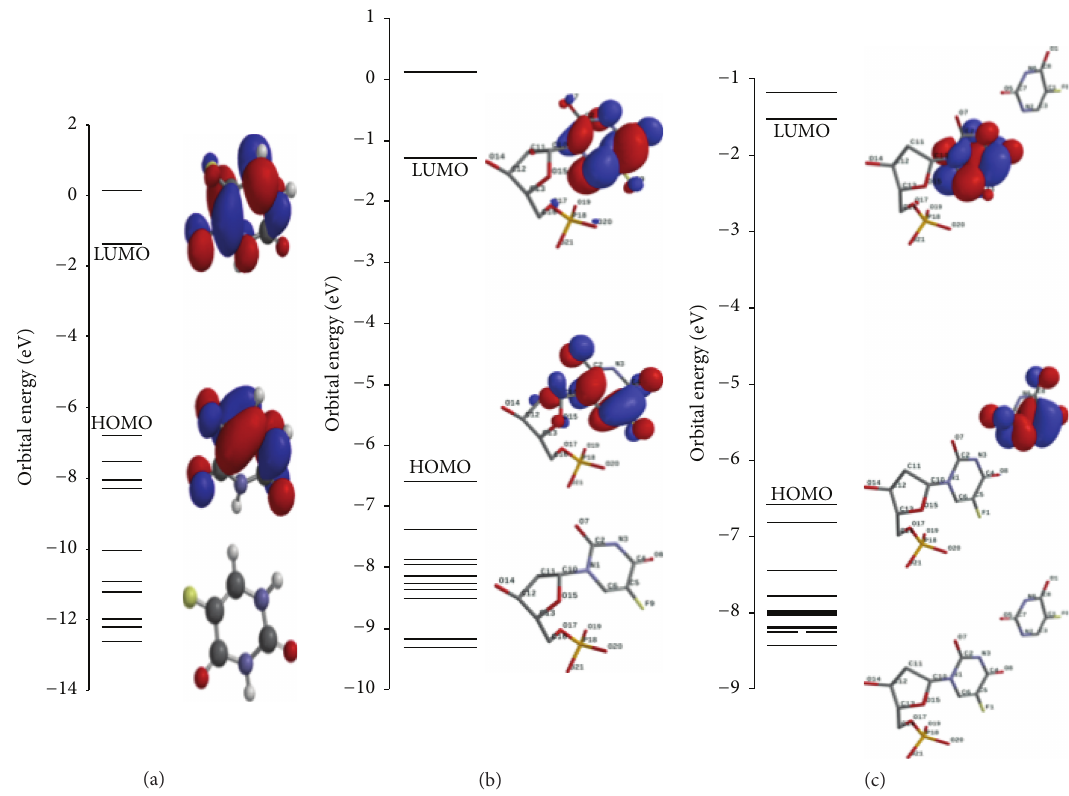
Figure 7: Frontier MOs of 5-FU (a), FdUMP (b), and the complex adduct of 5-FU and FdUMP (c) showing the charge transfer nature of the transition HOMO (mainly on 5-FU fragment to LUMO localized on FdUMP fragment of the complex).